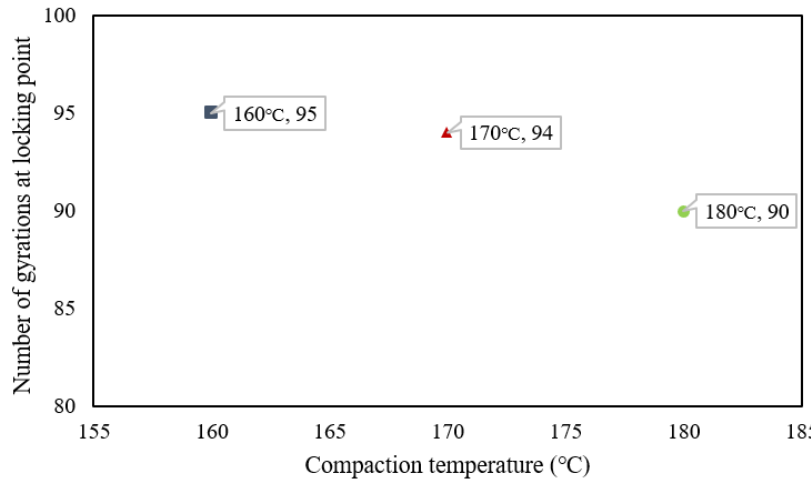
Figure 10. Traditional locking points with different compaction temperatures.